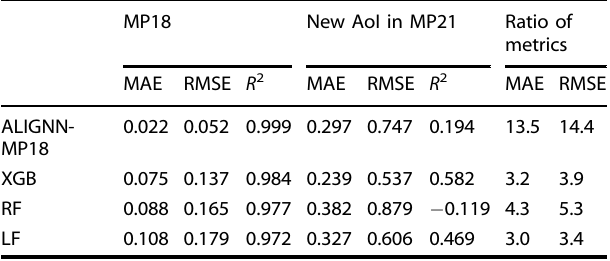
Table 3. Comparison of MAE (in eV/atom), RMSE (in eV/atom), and coef fi cient of determination ( R 2 ) between different ML models.